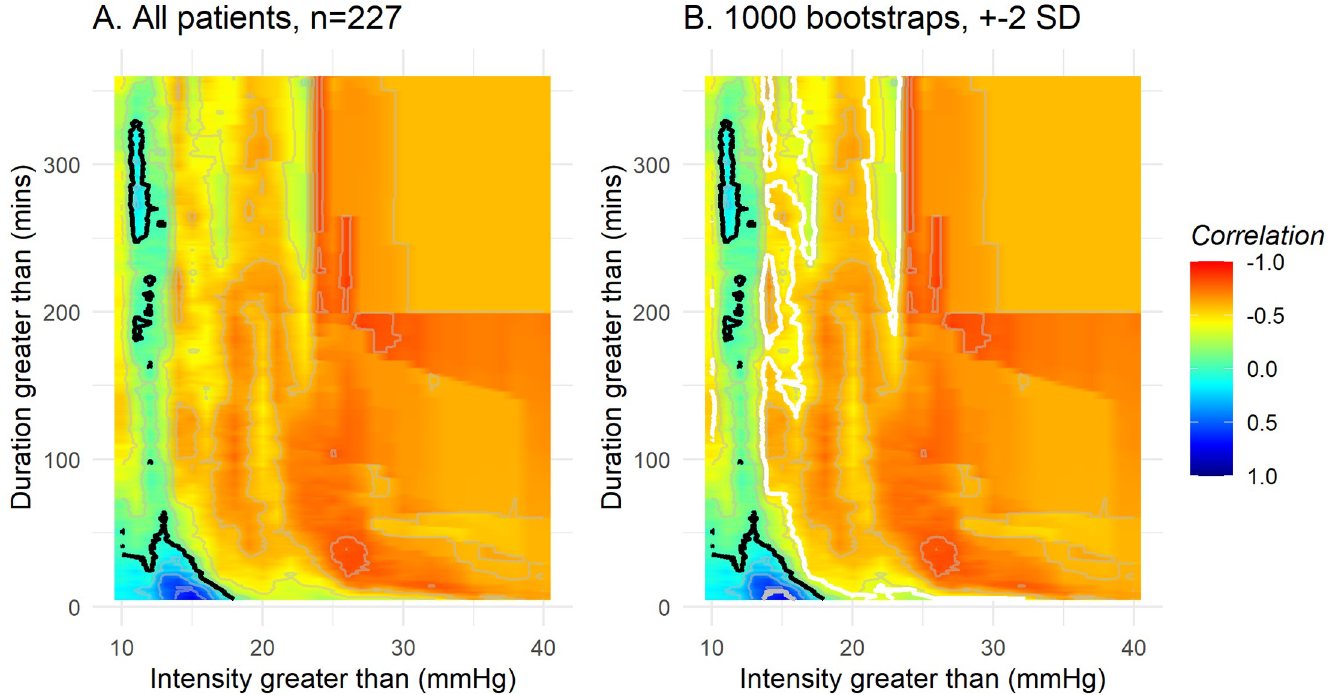
Fig 3. Correlation between number of events above thresholds of intracranial pressure and durations, and outcome (GOS-E score). Red indicates that ICP events are correlated to worse outcome at that specific ICP level and event duration on the map. A. The black line represents the transition line, where there is no correlation between number of events above threshold and outcome. B. The black line represents the mean transition line of 1000 bootstraps. The white lines represent the mean transition line +2 SD, while the grey line represents the mean transition line -2 SD. Above, and to the right, of the white line, there is a high degree of statistical certainty of events being associated with worse outcome, whereas below the grey line, the statistical certainty is high that events are not associated with harm.